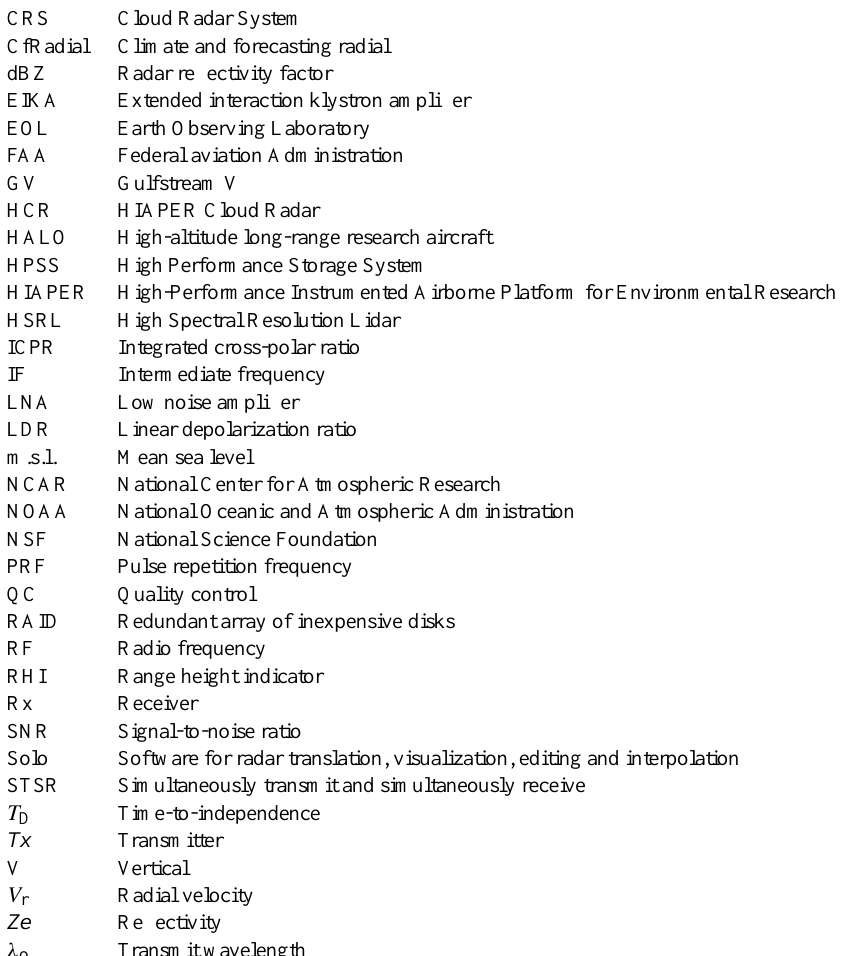
Table A1. List of